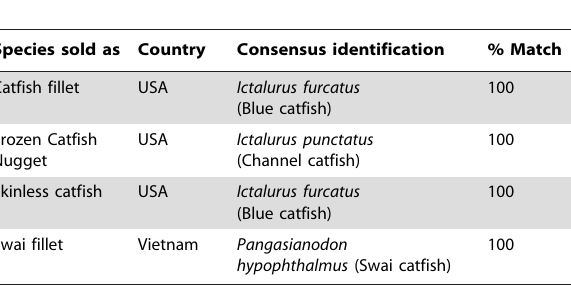
Table 3. Description of analyzed local market